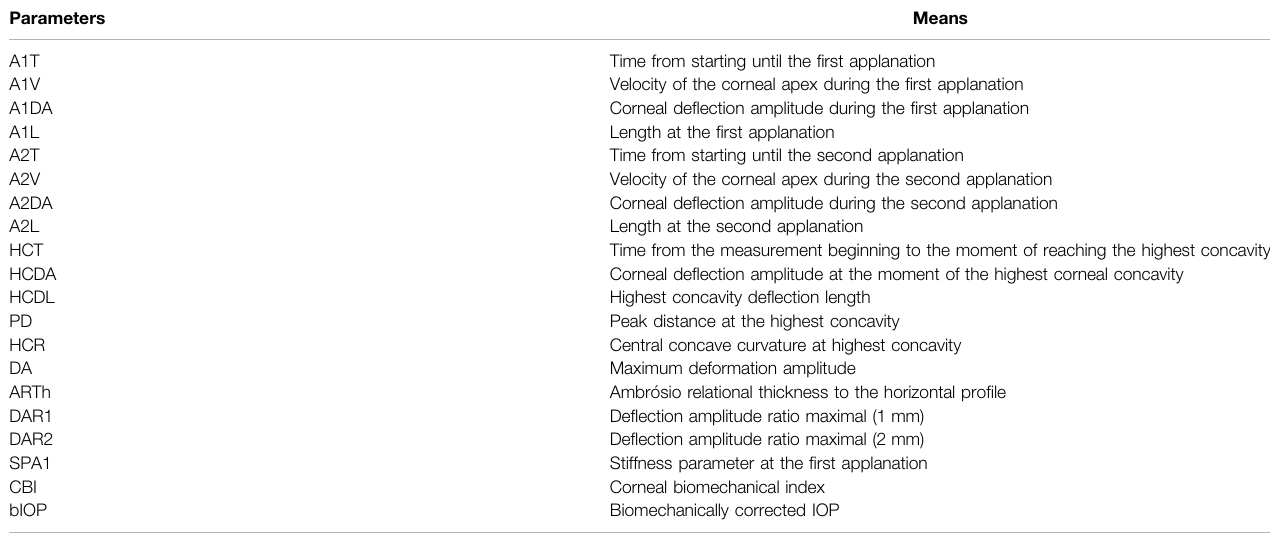
TABLE 1 | Corvis ST parameters of eyes by group.